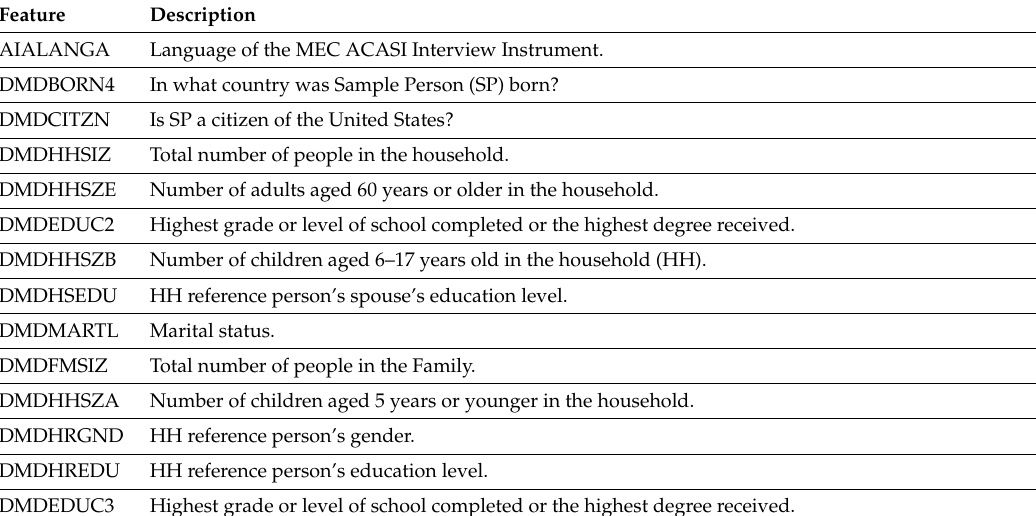
Table A1. Description of demographic